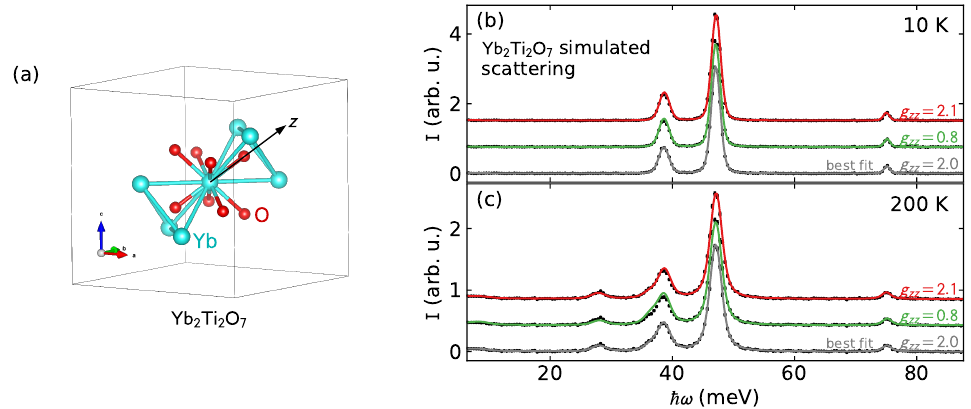
Figure 1: Pyrochlore Yb Ti O simulated scattering and fits. (a) shows the crystal 2 2 7 structure of Yb Ti O , with a three-fold axis along the [ 111 ] direction, which we 2 2 7 set as z . (b) and (c) show the point-charge model simulated scattering at 10 K and 200 K, respectively. The three curves show three fits to the simulated scattering data, offset along the y axis for clarity. The bottom (grey) shows the original model and best fit, the middle (green) shows the minimum g to within uncertainty, and the zz top (red) shows the maximum g to within zz